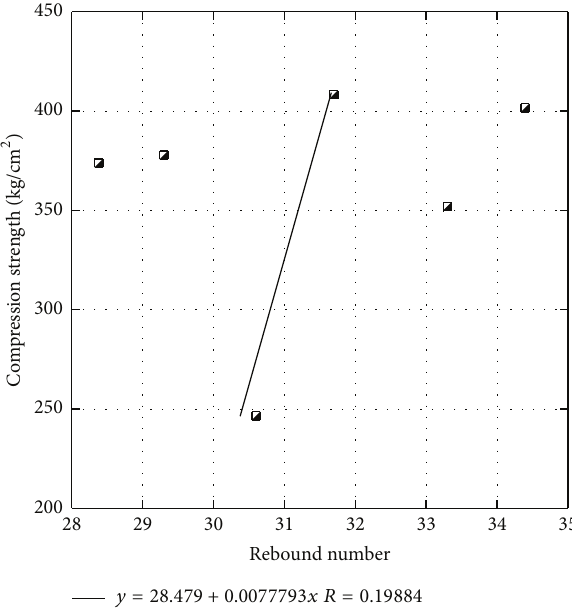
Figure 13: Correlation between hammer and compression strength for all trains.